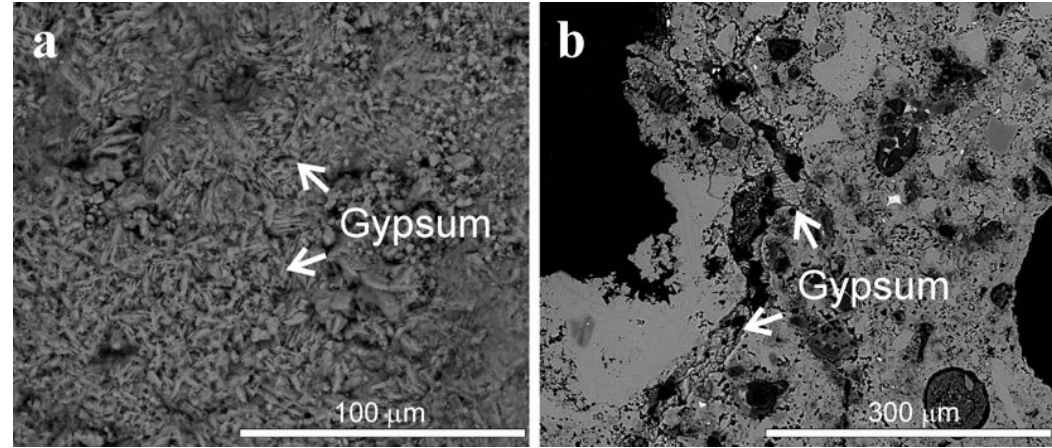
Figure 7. Backscattered (BSE) electron image of the secondary gypsum on the surface ( a ) and in cracks ( b ) of the sample KD-M-4-2.